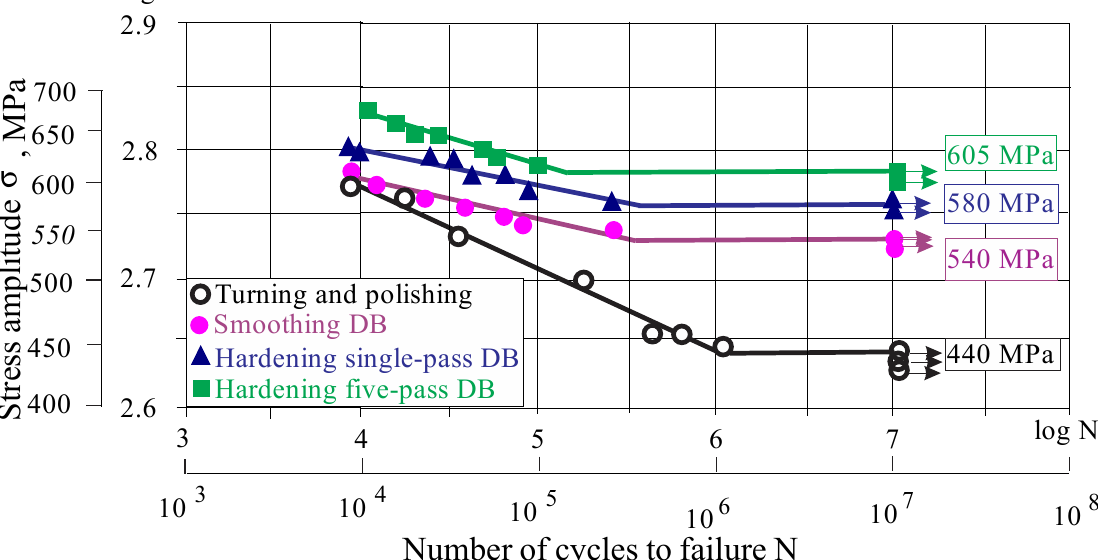
Figure 16. S–N curves.